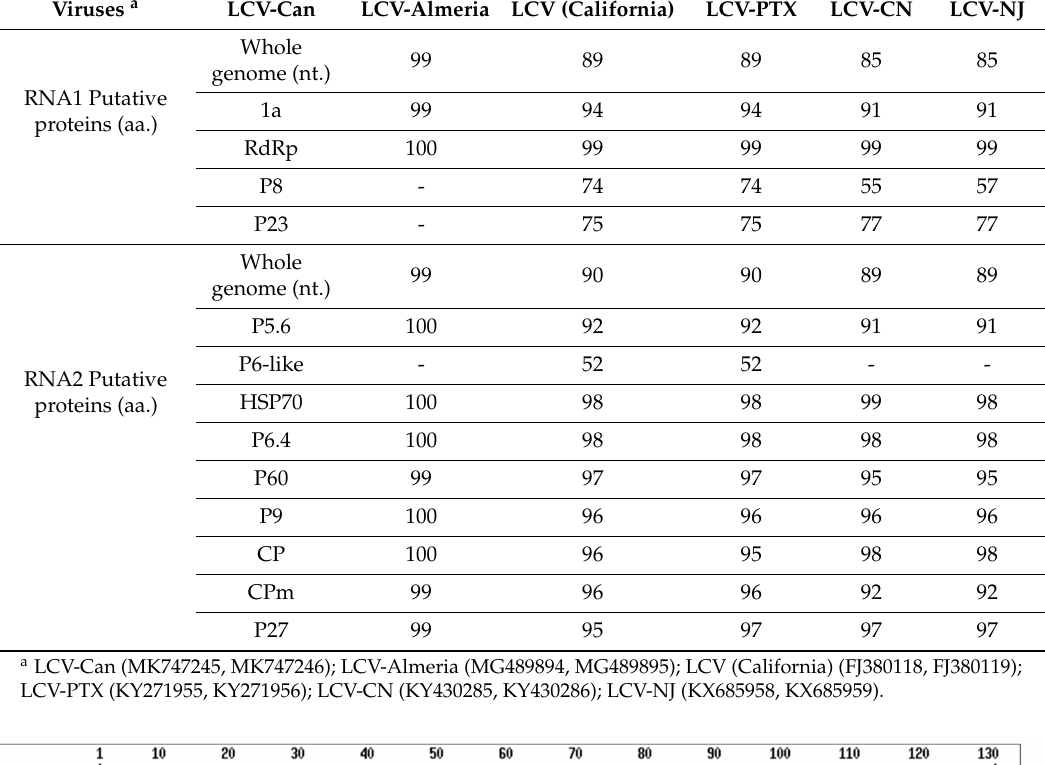
Table 2. Comparison (% identity) between nucleotide sequence of whole genome and the deduced amino acids of putative encoded proteins of LCV-Can and other LCV isolates. Viruses a